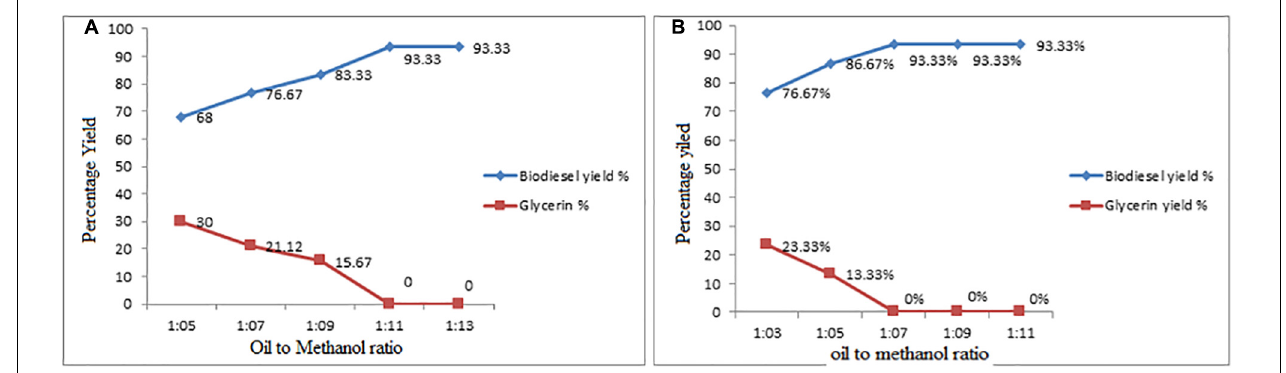
FIGURE 5 | (A,B) Effect of Oil: Methanol Molar Ratio on Esterification and Transesterification Steps.